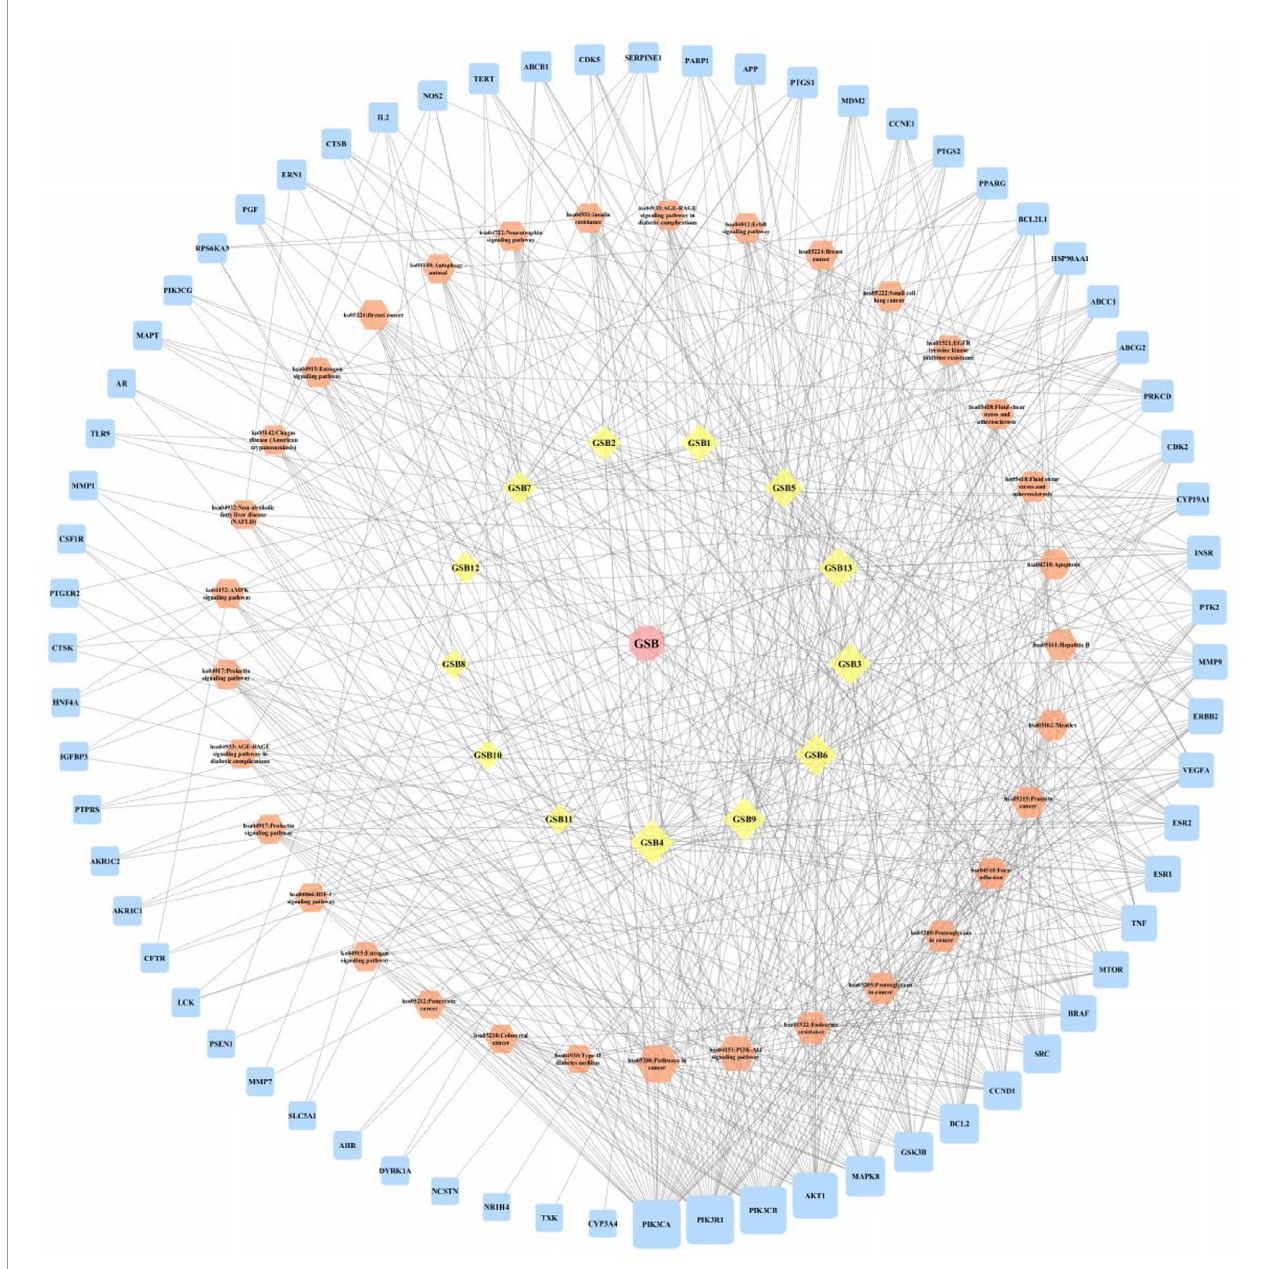
FIGURE 6 | The herb-compounds-targets-pathways network of TFDR. The light pink nodes represent TFDR, the light-yellow nodes represent its 13 compounds, the light orange nodes represent pathways and the light blue nodes represent the gene symbols. The size of node is proportional to the degree value and the edges represent interactions between the